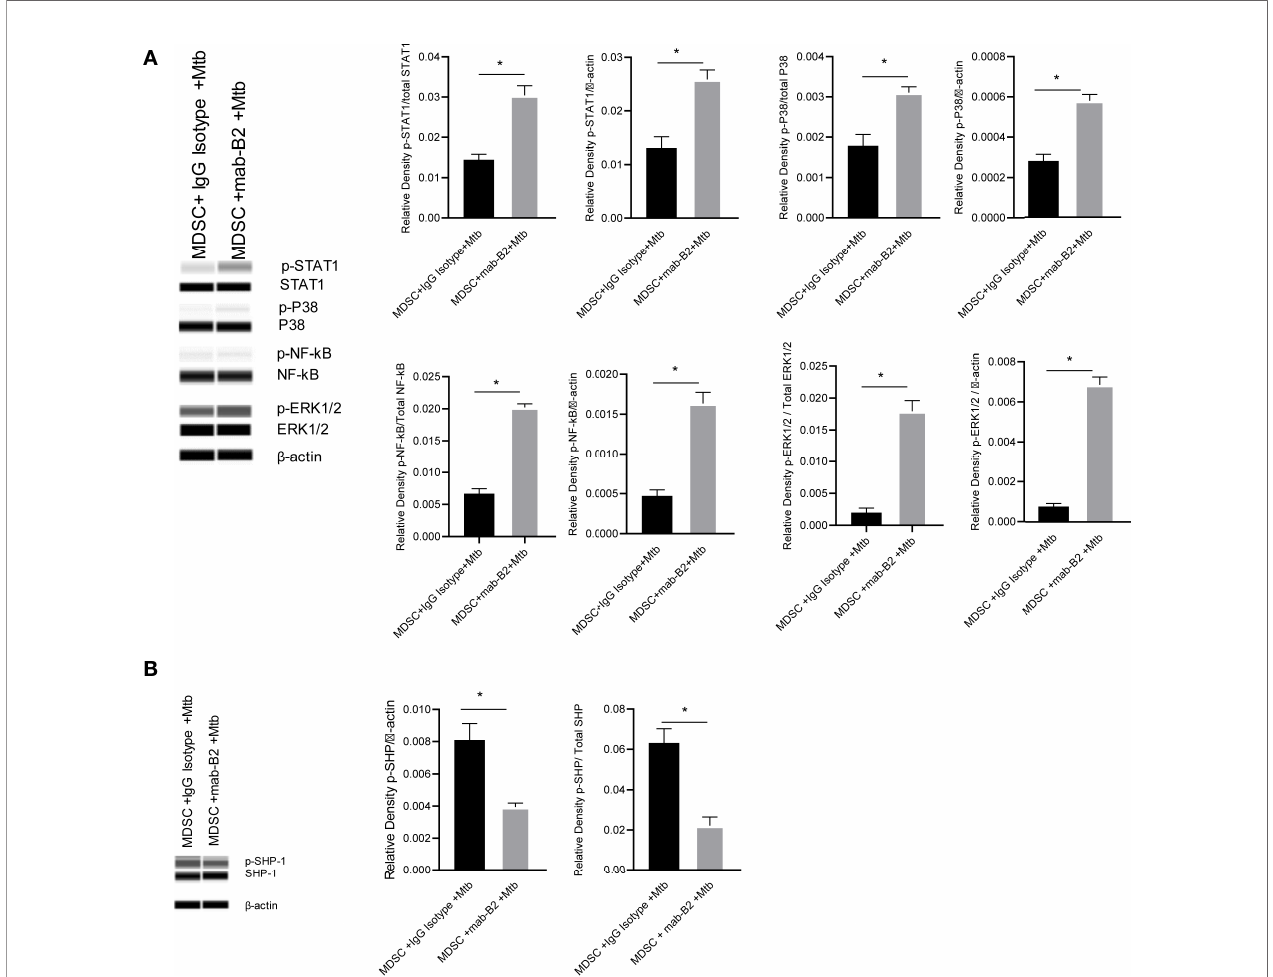
FIGURE 5 | LILRB2 antagonism drives the STAT1/NF- k B in fl ammatory pathway in Mtb-infected MDSCs. CD14 + /CD33 + bead-puri fi ed M-MDSCs derived from GM-CSF/ IL-6 cultured PBMCs from donors were infected for 4 h with Mtb H37Rv (MOI = 1), washed, and activated using either a monoclonal antibody to LILRB2 (mab-B2) or its IgG isotype. MDSC lysates were collected at 18 h post infection in RIPA buffer for Western blots and densitometry. (A) Immunoblot of phosphorylated STAT1, p38 MAPK, NF- k B, and ERK1/2 in MDSCs treated as above. Densitometry shown to the right (* p < 0.02, unpaired t -test). (B) Immunoblot of phosphorylated SHP1 in MDSCs treated as above (* p < 0.02 unpaired t -test) (SHP2 was not affected; not shown; 1 of 2 similar experiments